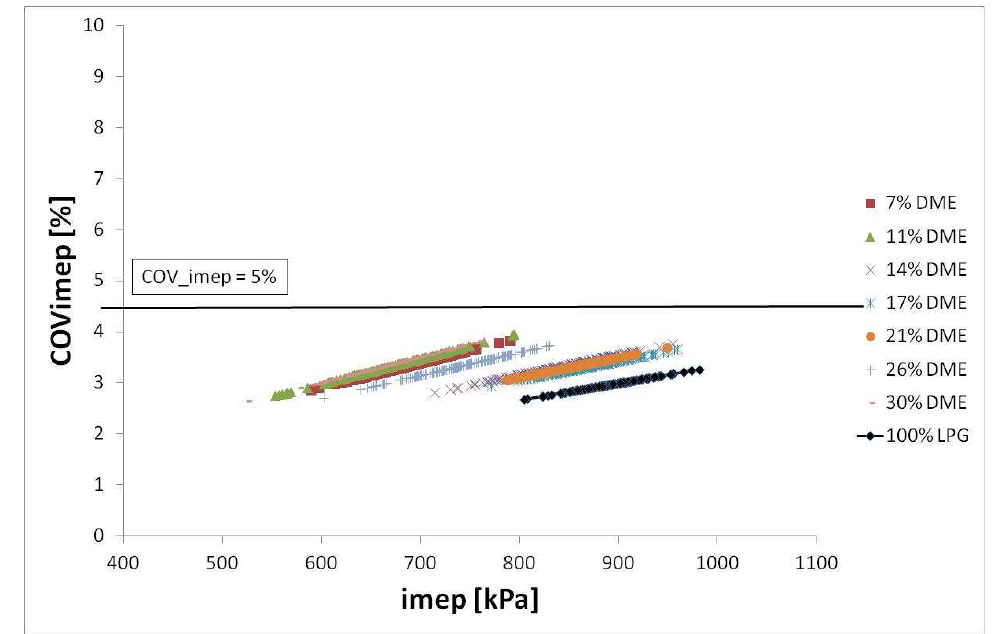
Figure 7. Covariance of imep values.